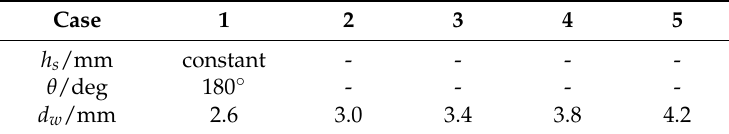
Table 1. Variation in thickness of the selector